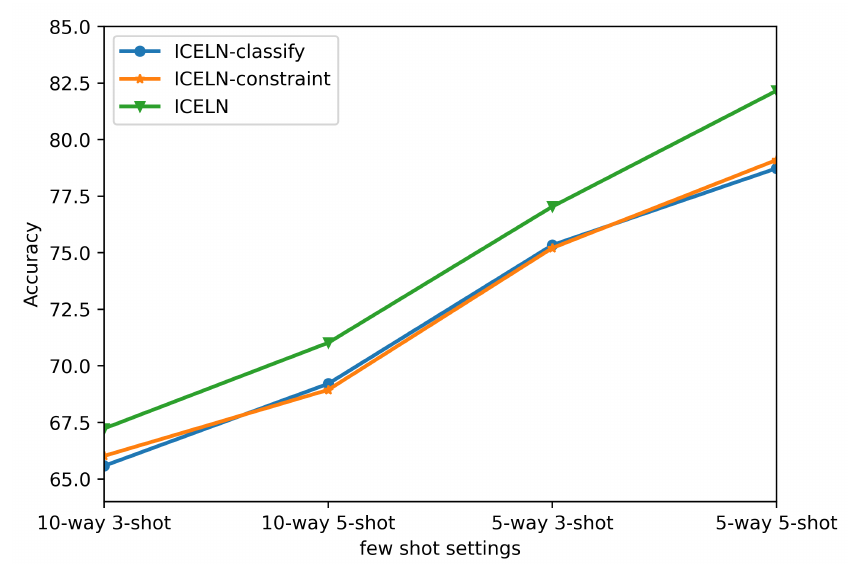
Figure 7. Ablation study on Amazon-Electronics.